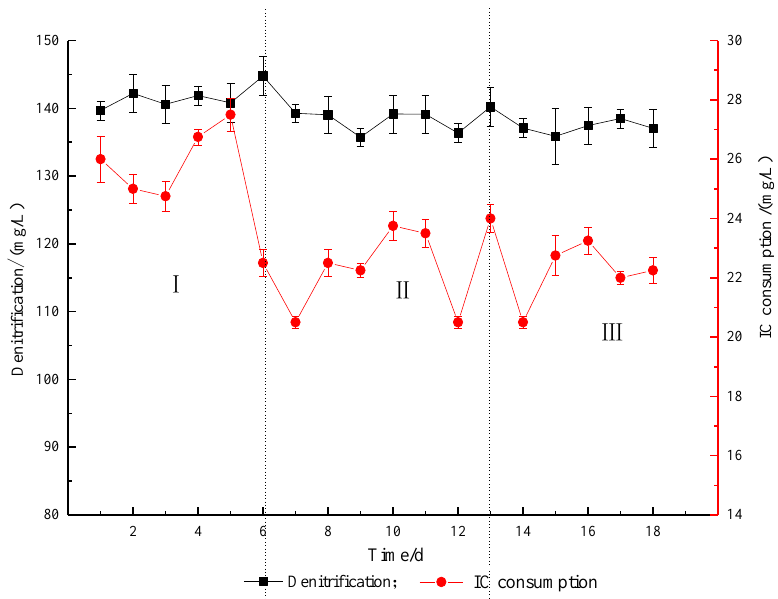
Figure 6. Relationship between inorganic carbon (IC) consumption and the amount of denitrification in anammox in hydraulic retention time (HRT) experiments; Stages I, II, and III indicate that HRT is 33.4, 24, and 14.5 h, respectively.